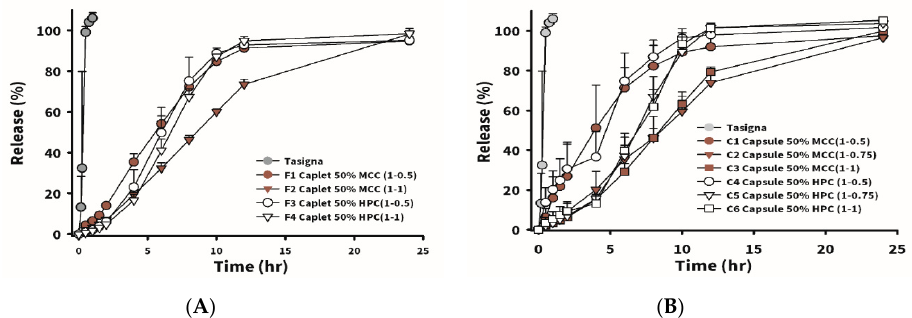
Table 6. Composition of formulations F1–F4 and C1–C6.